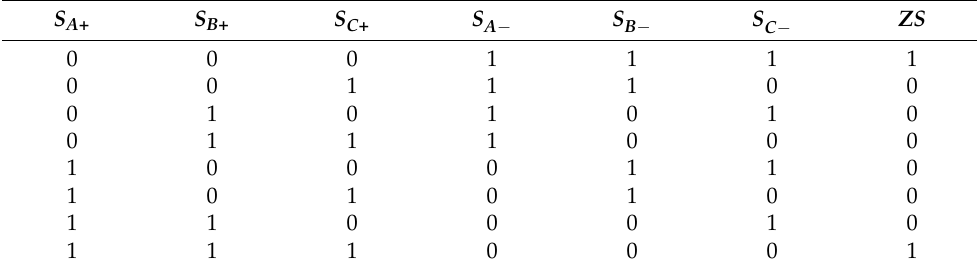
Figure 4. Logic diagram of the PWM pulses generation with the STSs injection by means of both the zero-sync and conventional methods. Table 1. The available SPWM pulses combinations and the ZS signal value.